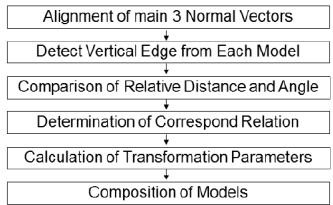
Figure 10. Flow of Registration by 3D